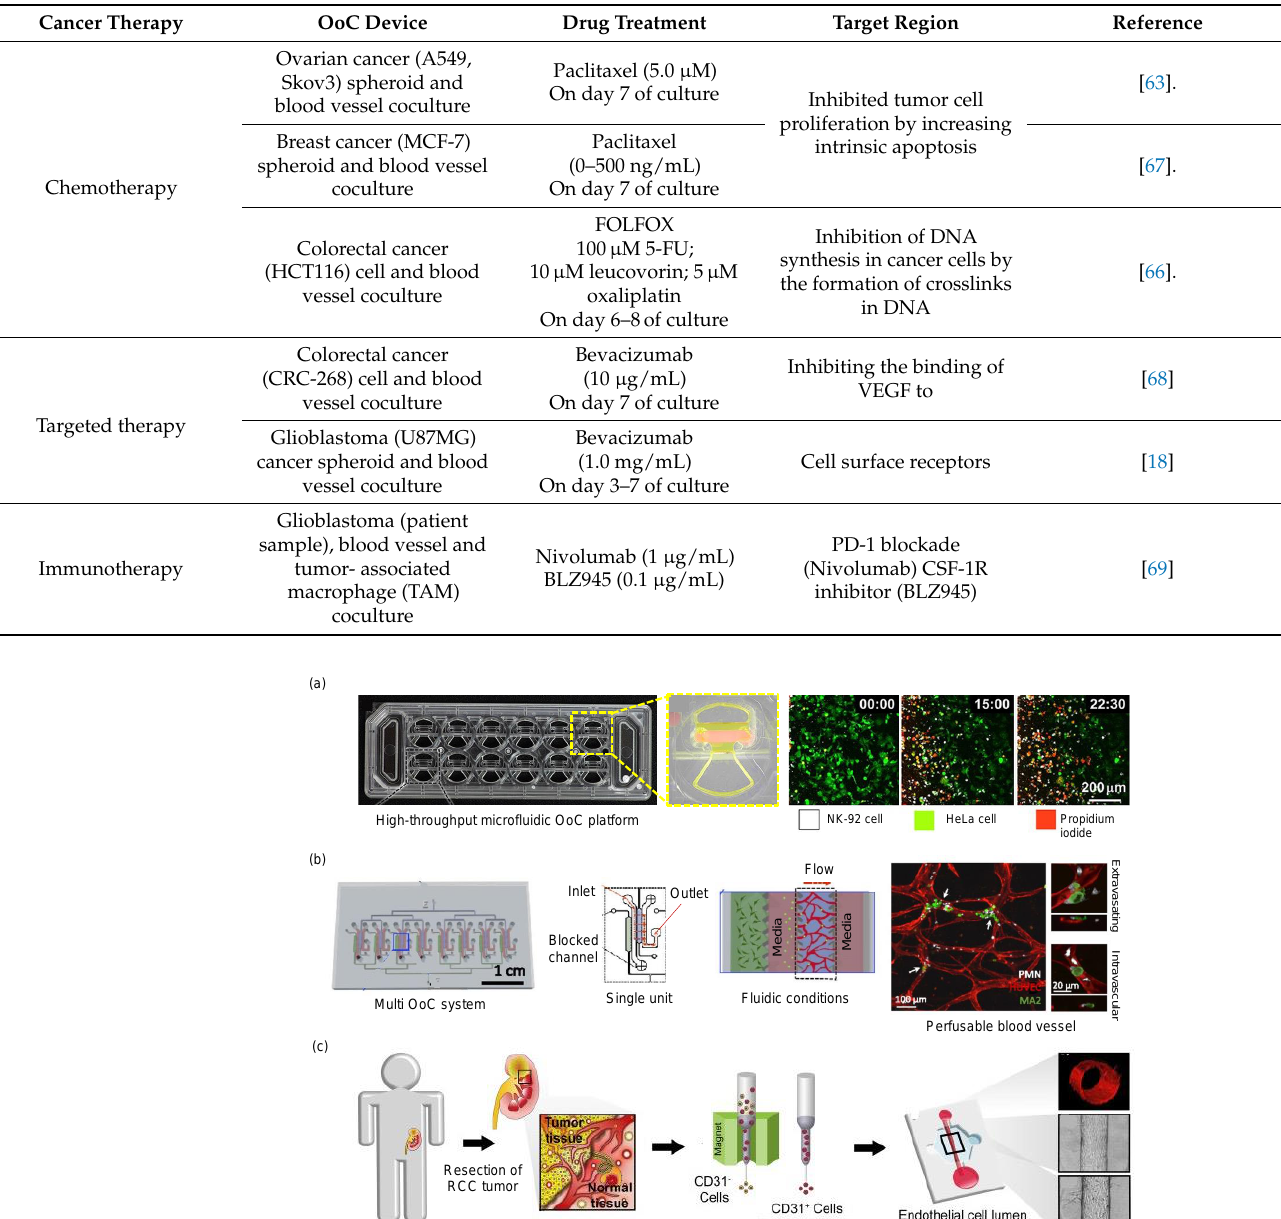
Table 3. Examples of cancer-vascular models with anticancer drug screening.